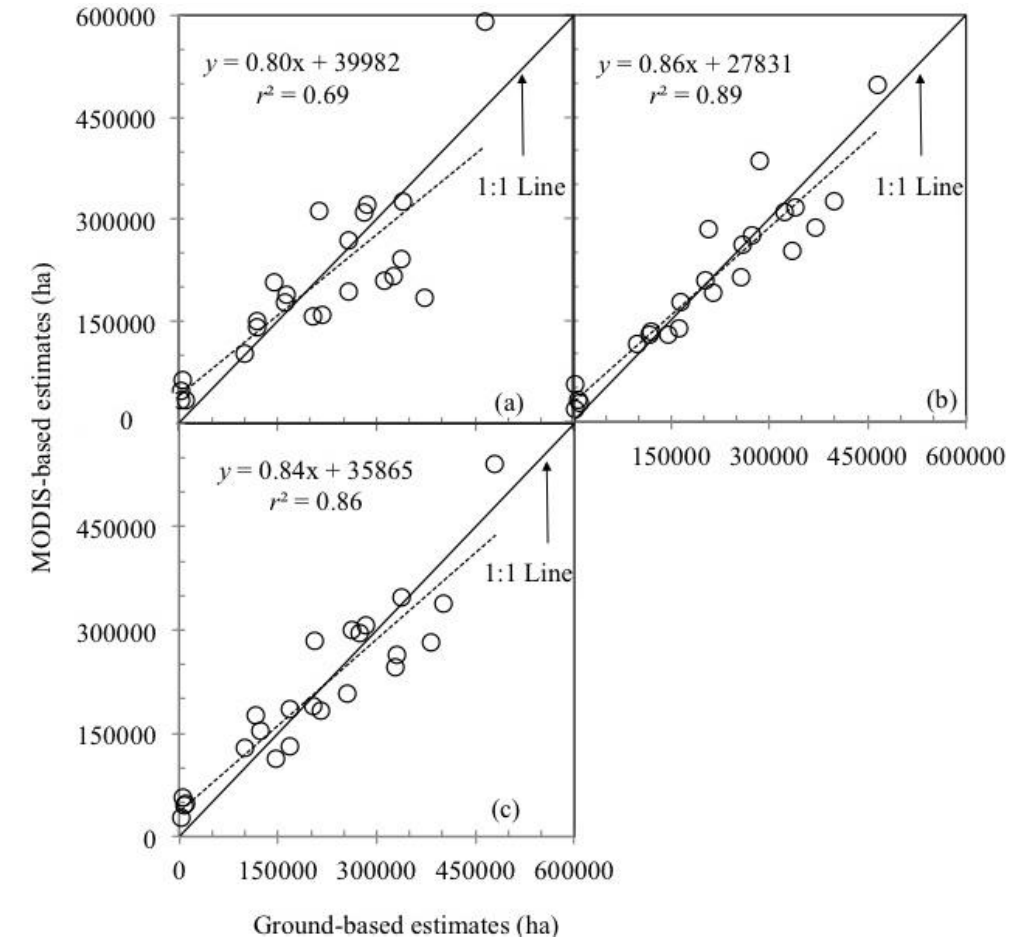
Figure 5. Relation between ground and MODIS-based estimates of boro rice cultivation areas at 23 districts (shown in Figure 1b) during: ( a ) 2010; ( b ) 2011; and ( c )